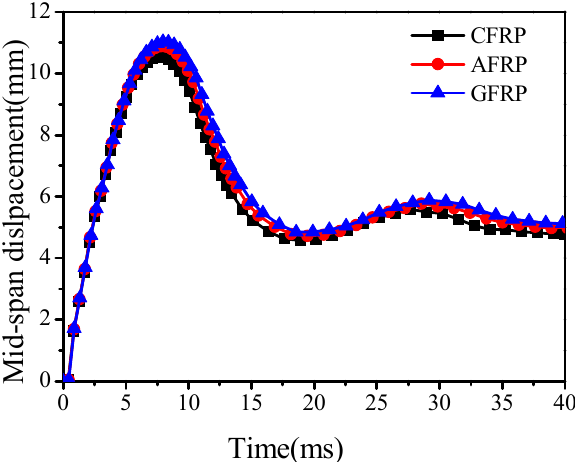
Figure 17. Mid-span displacement-time histories of T-beams strengthened with different FRP material.